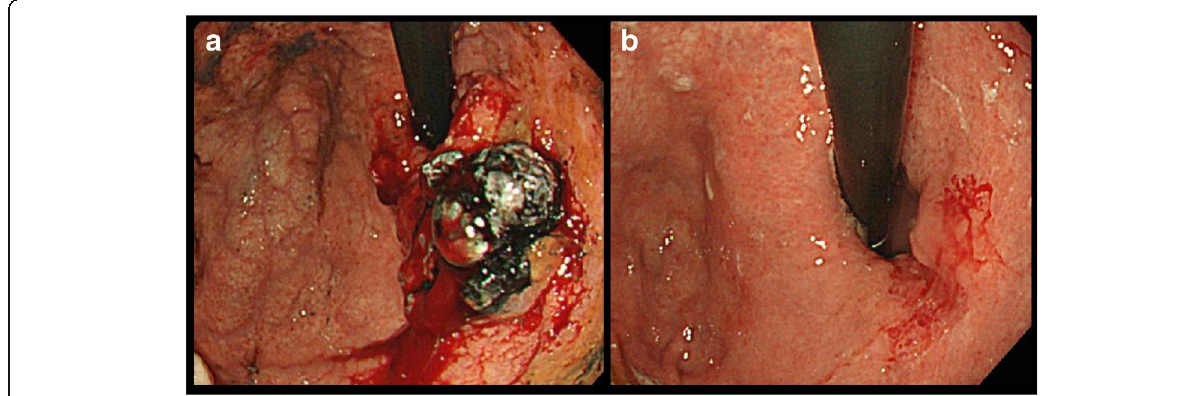
Fig. 1 Endoscopy findings. a Endoscopy before chemotherapy revealed Borrmann type 3 cancer in the lesser curvature of the stomach. b Endoscopy after chemotherapy showed a scar-like flat lesion in the lesser curvature of the remnant